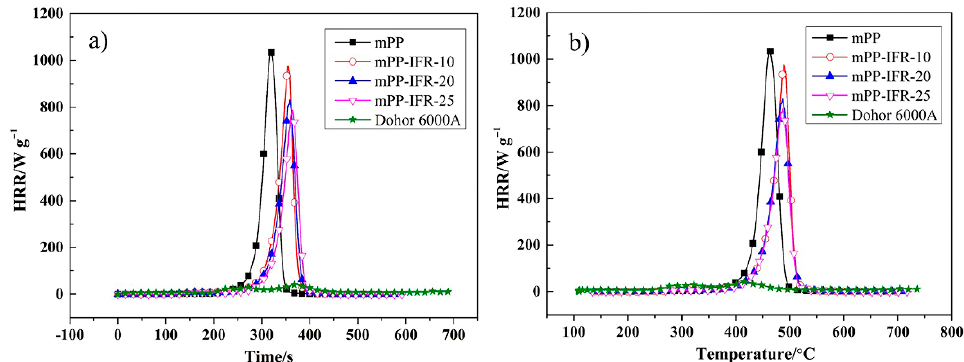
Figure 8. HRR-Time curve of the fibers ( a ), HRR-Temperature curve of the fibers ( b ). Table 5. Results of MCC tests.